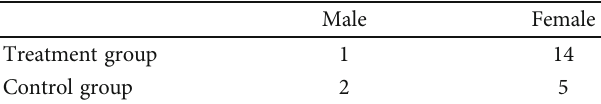
Table 1: Male and female distribution.